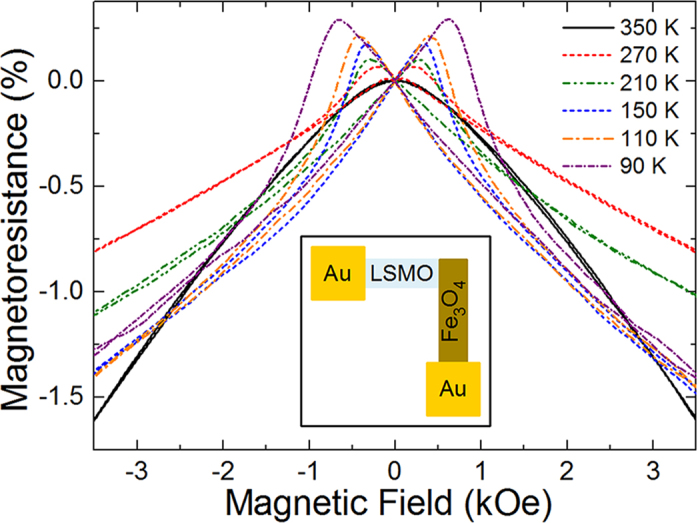
Magnetoresistance for a Fe3O4/La0.7Sr0.3MnO3/SrTiO3 (001) spin valve device with the Fe3O4 grown at 2.5 J/cm2 and 400 °C on the 2D/3D-to-2D phase boundary. Inset shows schematic for La0.7Sr0.3MnO3 (LSMO)/Fe3O4 spin valve device.